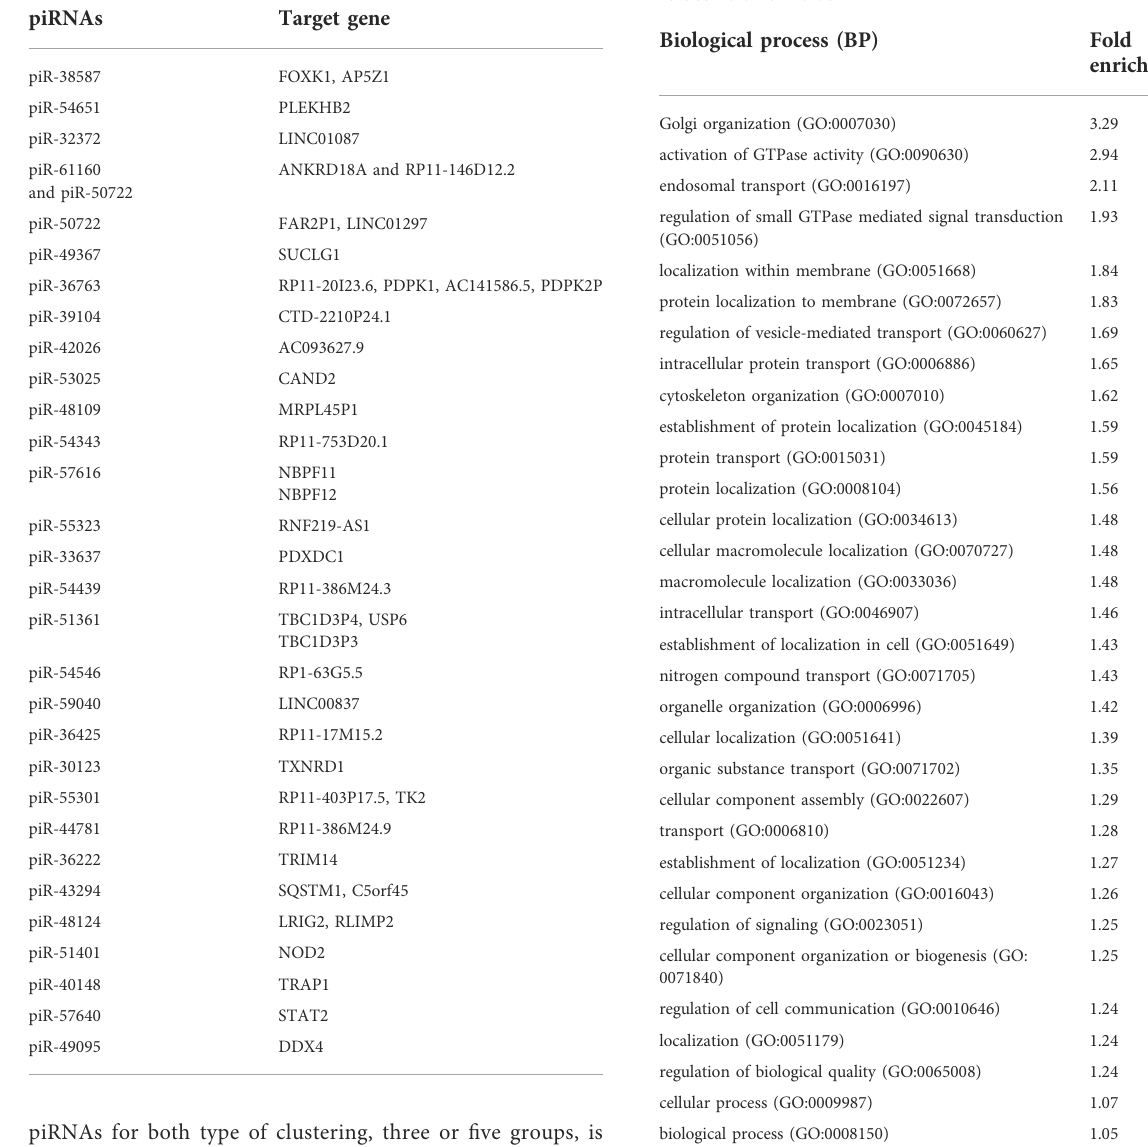
TABLE 5 Gene Ontology (GO), biological processes (BP) analysis for the top gene targets of piRNAs (time point, RSV 24 h p.i) with p values < 0.01 or <